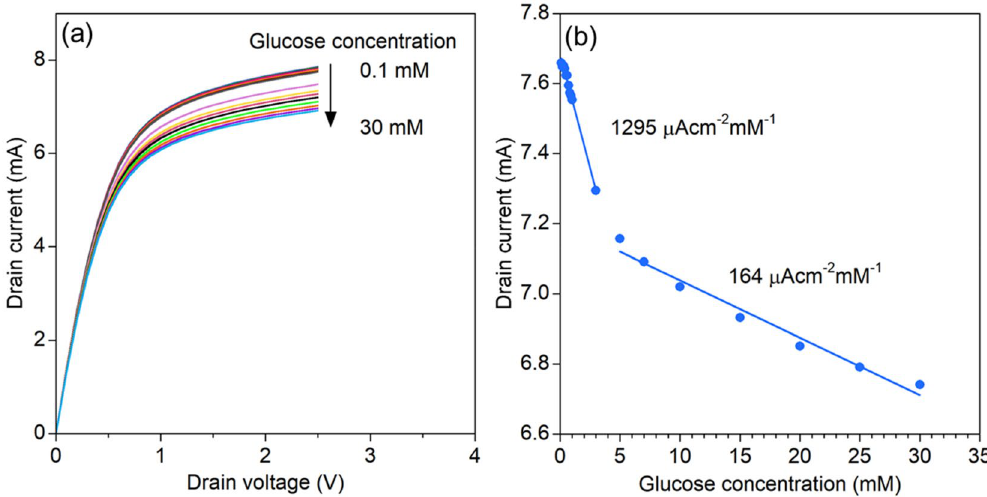
Fig. 9 a I – V output characteristics of the EG-FET device configuration with different glucose concentrations. b The plot of drain-source DS DS current as a function of glucose concentration of the EG-FET